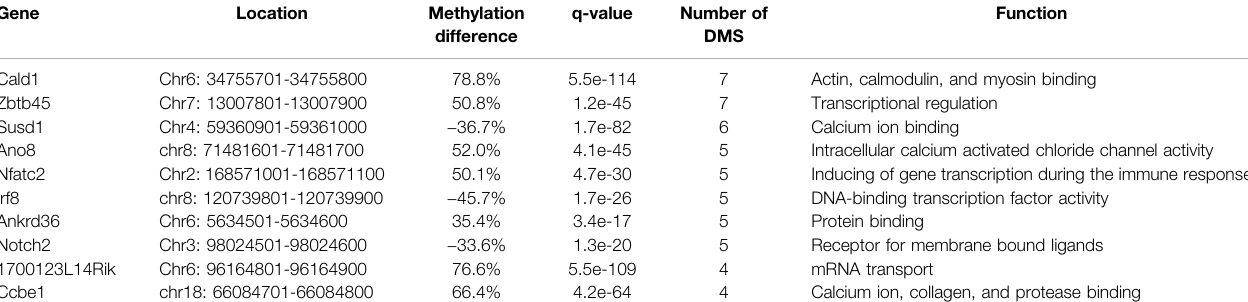
TABLE 1 | The top 10 most differentially methylated regions (DMRs) identi fi ed from caput vs. testicular spermatozoa.